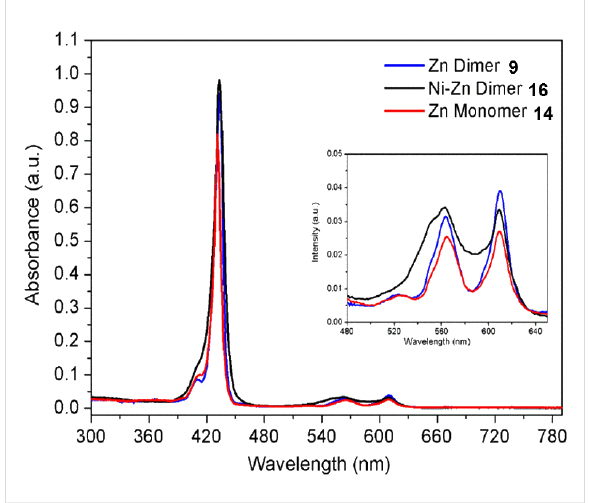
Figure 6: UV–vis of symmetric and unsymmetric triptycene porphyrin dimers 9 and 16 , and the triptycene porphyrin monomer 14 in CHCl 3 .